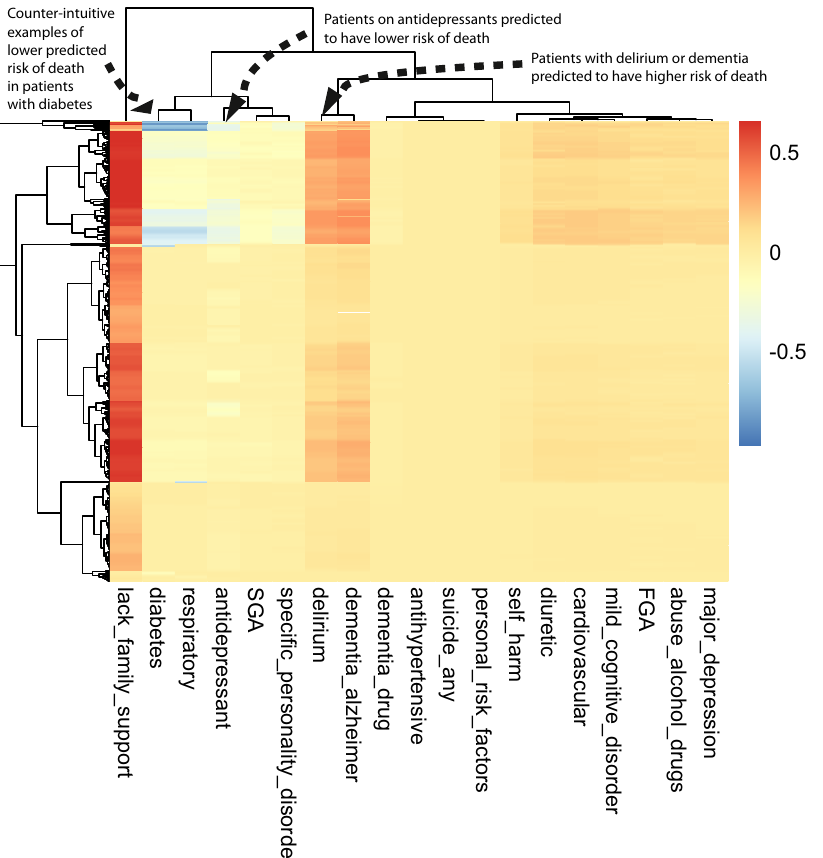
Fig. 4 Class-contrastive heatmap for the logistic regression model. Visualization of the amount of change predicted in the probability of death by setting a particular feature to 1 versus 0 (using a logistic regression model). Rows represent patients and columns represent features. Predictions are made on the test set using the trained logistic regression model. The arrows indicate groups of patients with low predicted risk of death (shown in blue on the heatmap) and high predicted risk of death (shown in red). The arrow on the top left indicates a group of patients having a counter-intuitive characteristic of having diabetes and still have low predicted risk of death. The second arrow on the top left indicates another group of patients on antidepressants. These patients are predicted (using the logistic regression model) to have a lower risk of death. There is a third group of patients with delirium or dementia in Alzheimer ’ s disease (shown with an arrow) who are predicted to have a higher risk of death. The heatmap also shows a hierarchical clustering dendrogram which is performed using an Euclidean distance metric and complete linkage. FGA: fi rst-generation antipsychotics, SGA: second-generation